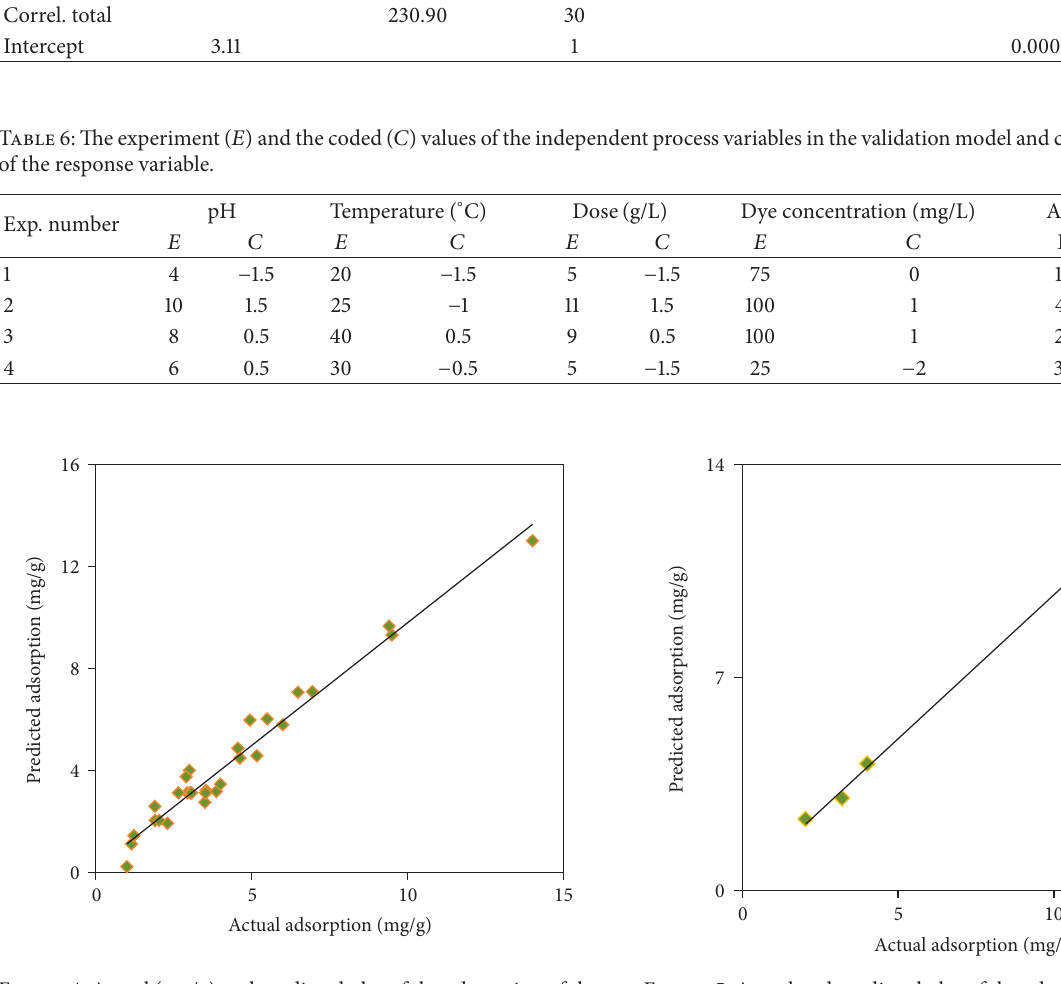
Figure 5: Actual and predicted plot of the adsorption (mg/g) of the AB1 for the model validation